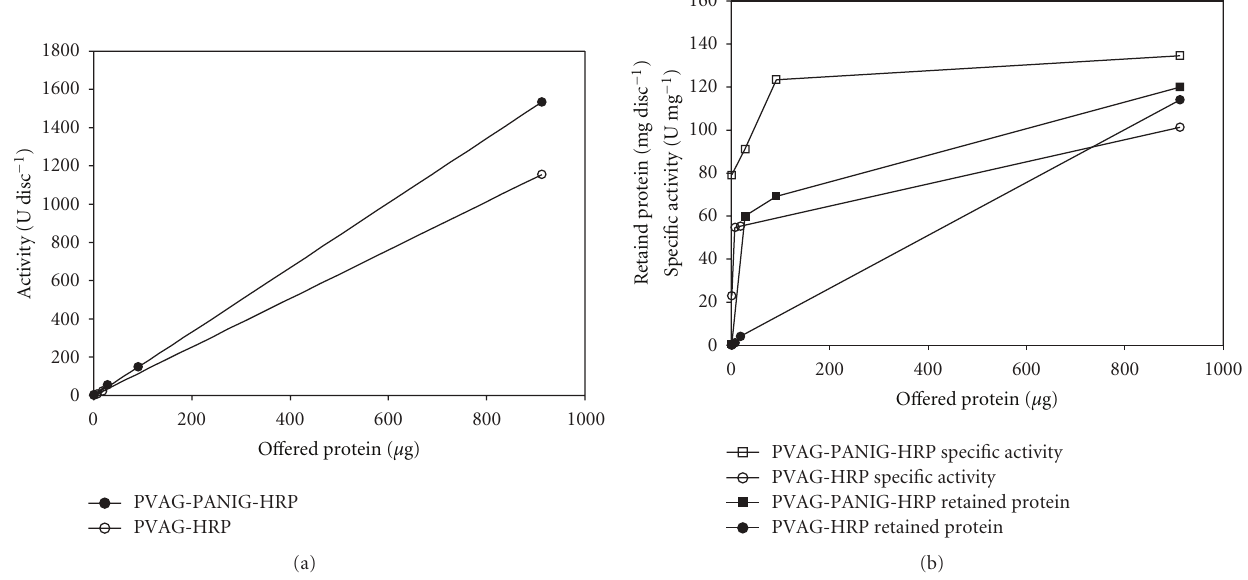
Figure 2: Relationship between o ff ered and retained activity (a), protein (b),and specific activity (b) of the immobilized HRP on the PVAG- PANIG disc.